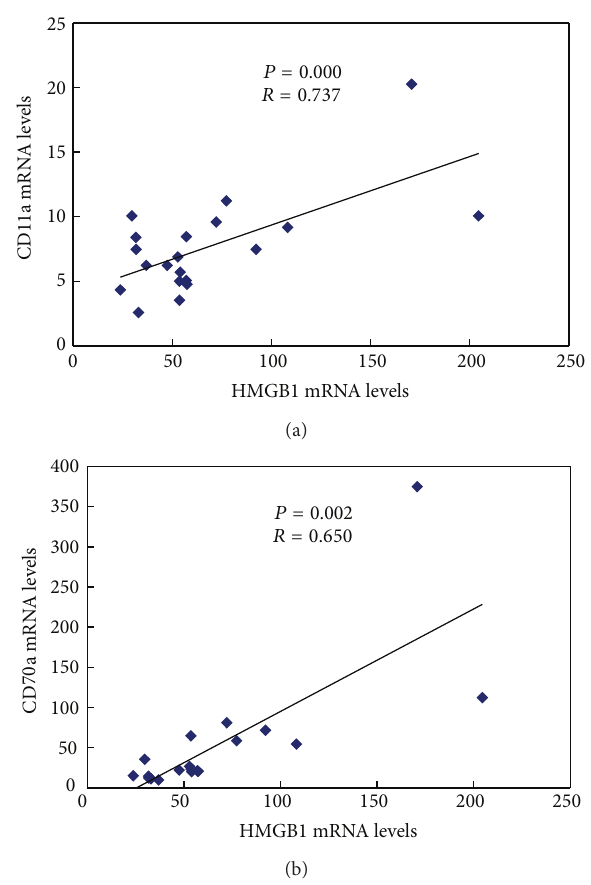
Figure 4: Correlation between HMGB1 mRNA and CD11a and CD70 mRNA. Gene expression of HMGB1, CD11a, and CD70 was assessed by real-time PCR. Correlation between HMGB1 mRNA and (a) CD11a mRNA and (b) CD70 mRNA is shown for CD4 + T cells in SLE patients and controls.